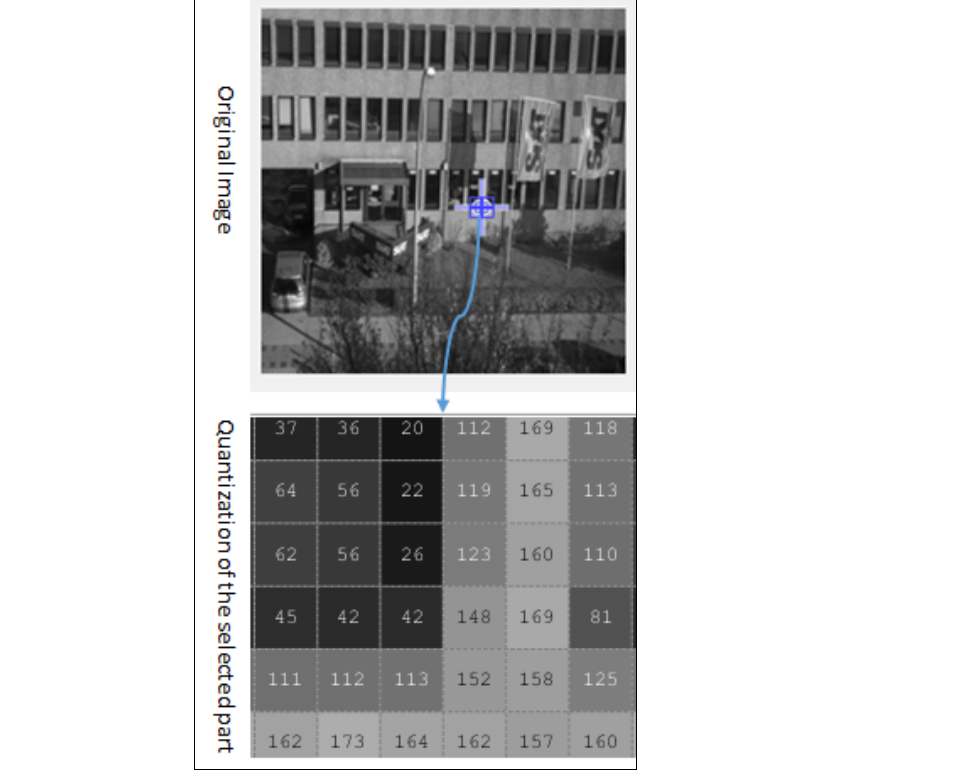
Figure 2. An 8-bit greyscale image.